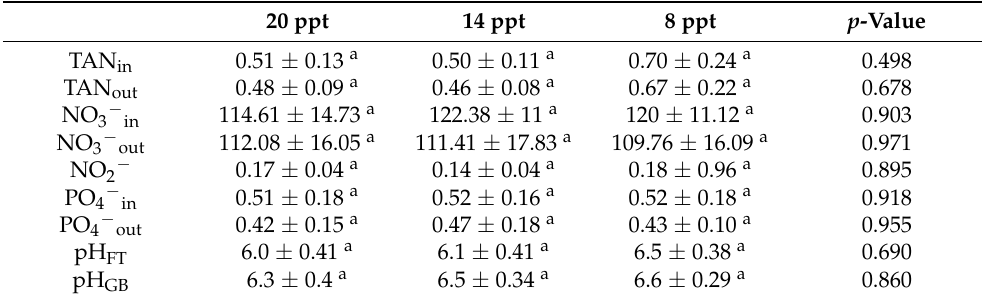
Table 1. Rearing conditions (pH FT , pH GB ) and dissolved nutrients (TAN in , TAN out , NO 3 − in , NO 3 − out , PO 4= in , PO 4= out , and NO 2 − ) in the fish and hydroponic of the brackish aquaponic system over the experimental period of 45 days. 20 ppt 14